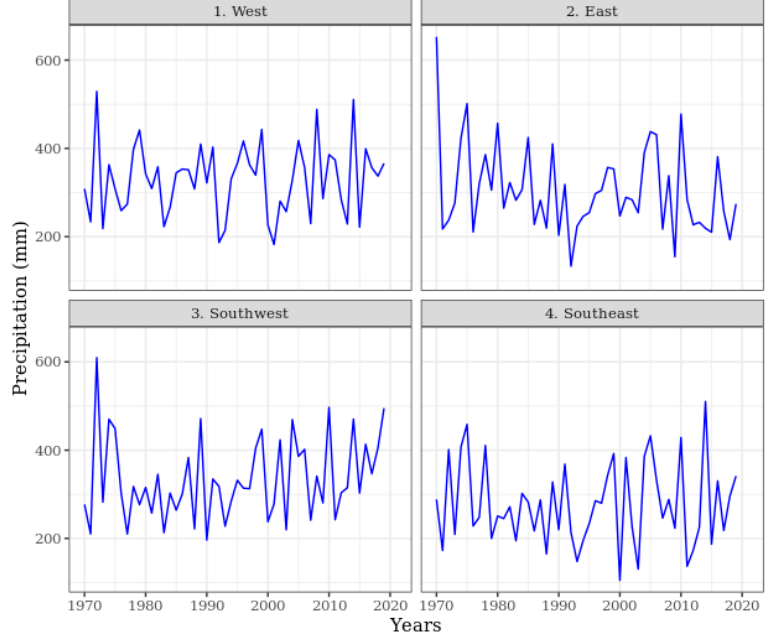
Figure 8. Amount of seasonal * rainfall in the four investigated regions (1970–2019). * Calculated for the vegetation period of maize (May–August).